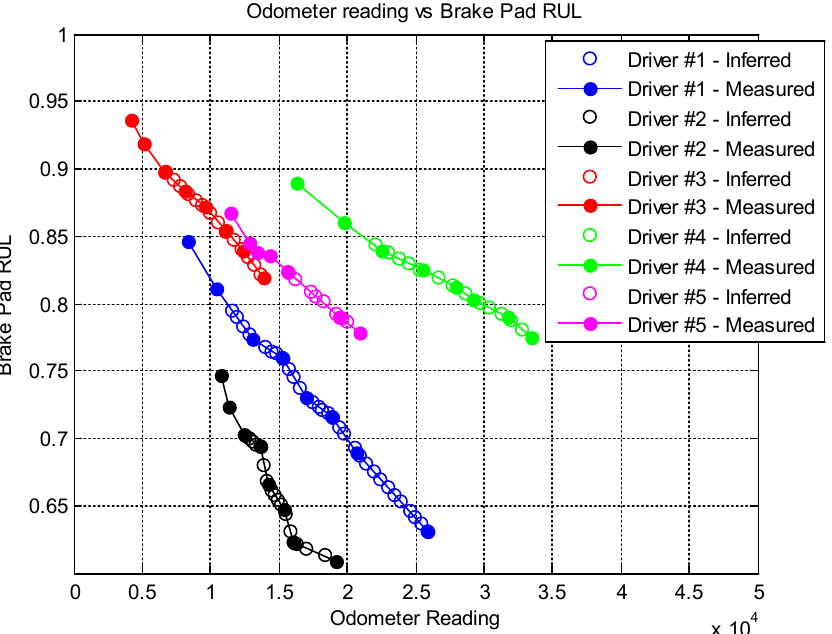
Figure 16. Measured (solid dots) and inferred (unfilled circles) RUL of front driver’s side brake pad thickness.